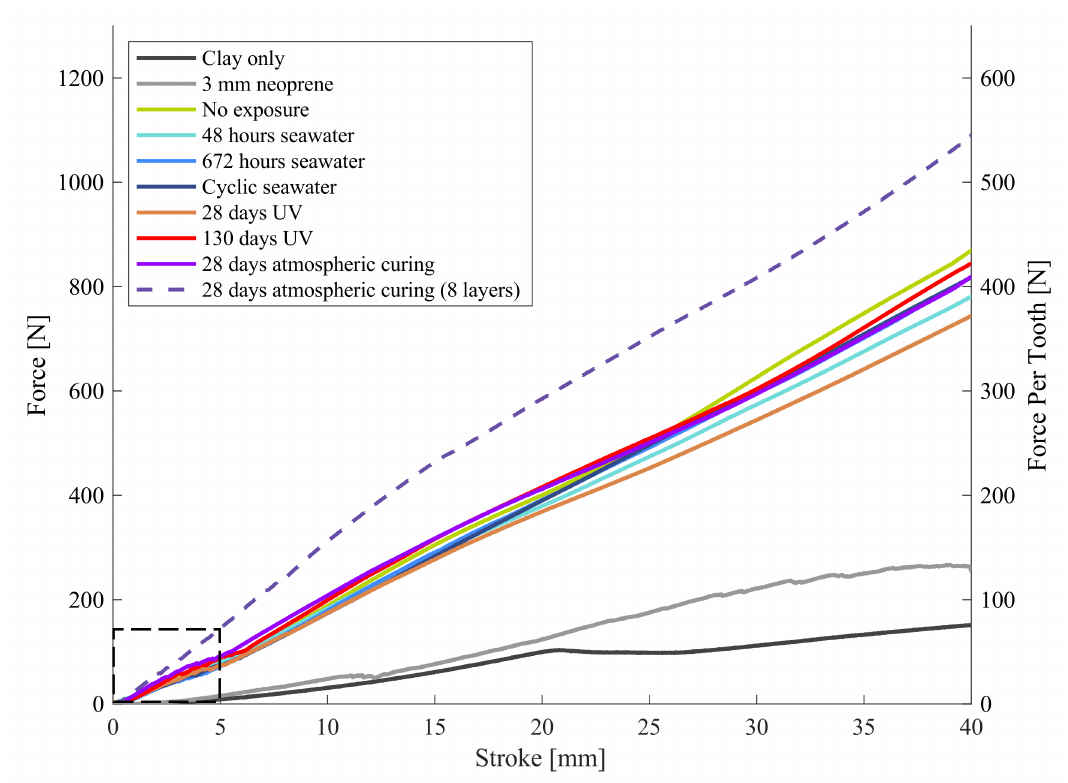
Figure 4. Force versus